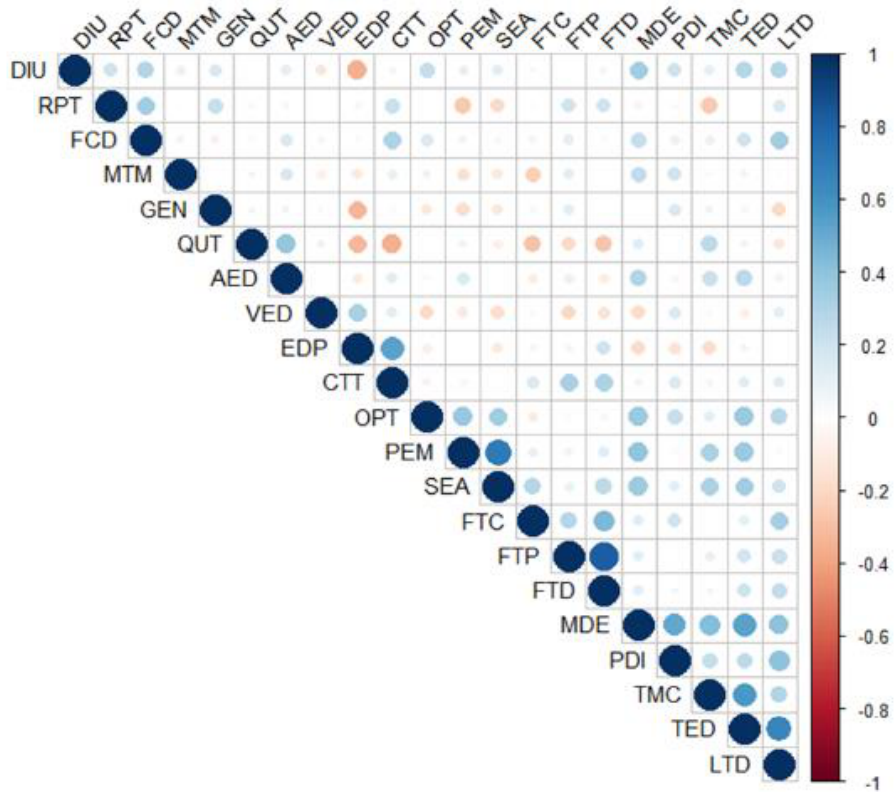
Figure 2. Correlogram chart. Linear correlations among study variables .